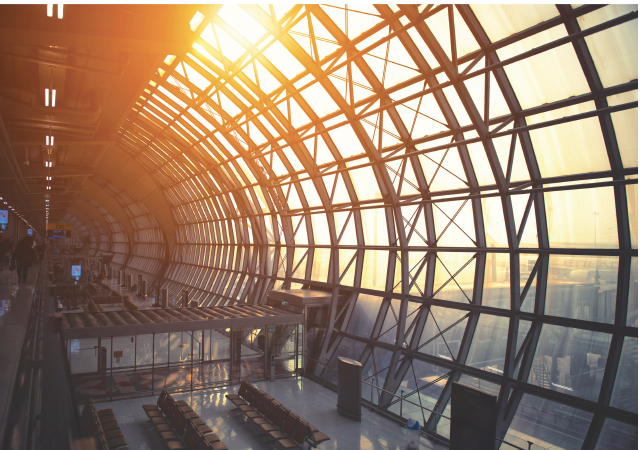
Figure 1. Suvarnabhumi International Airport in Thailand was constructed with excessively trans- parent materials, causing sunlight to come into the indoor space, particularly direct